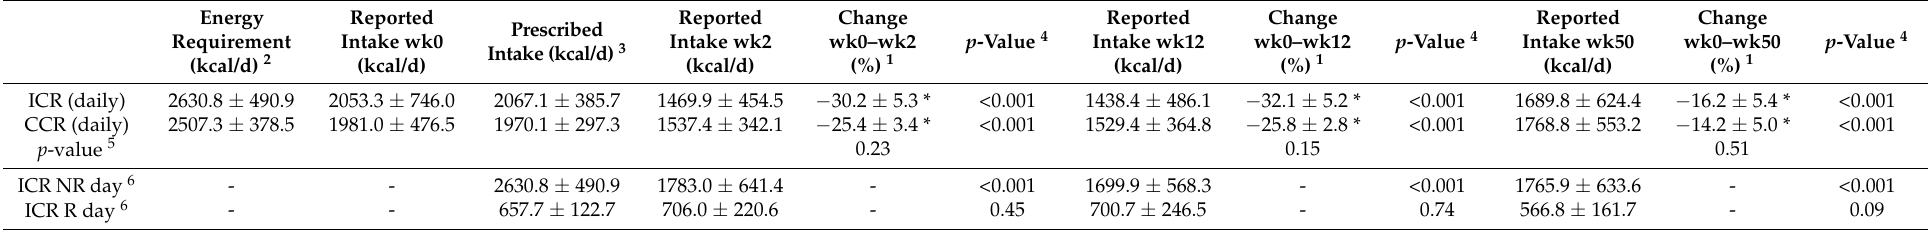
Table 2. Estimated isoenergetic energy requirement, calculated prescribed energy intakes according to the intervention and reported energy intakes at wk0, wk2, wk12 and wk50 1